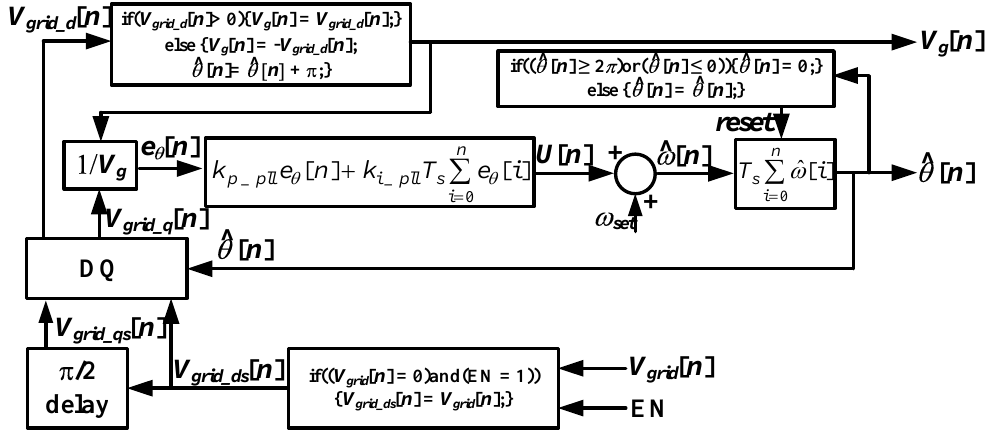
Figure 6. Block diagram of the phase locked loop.